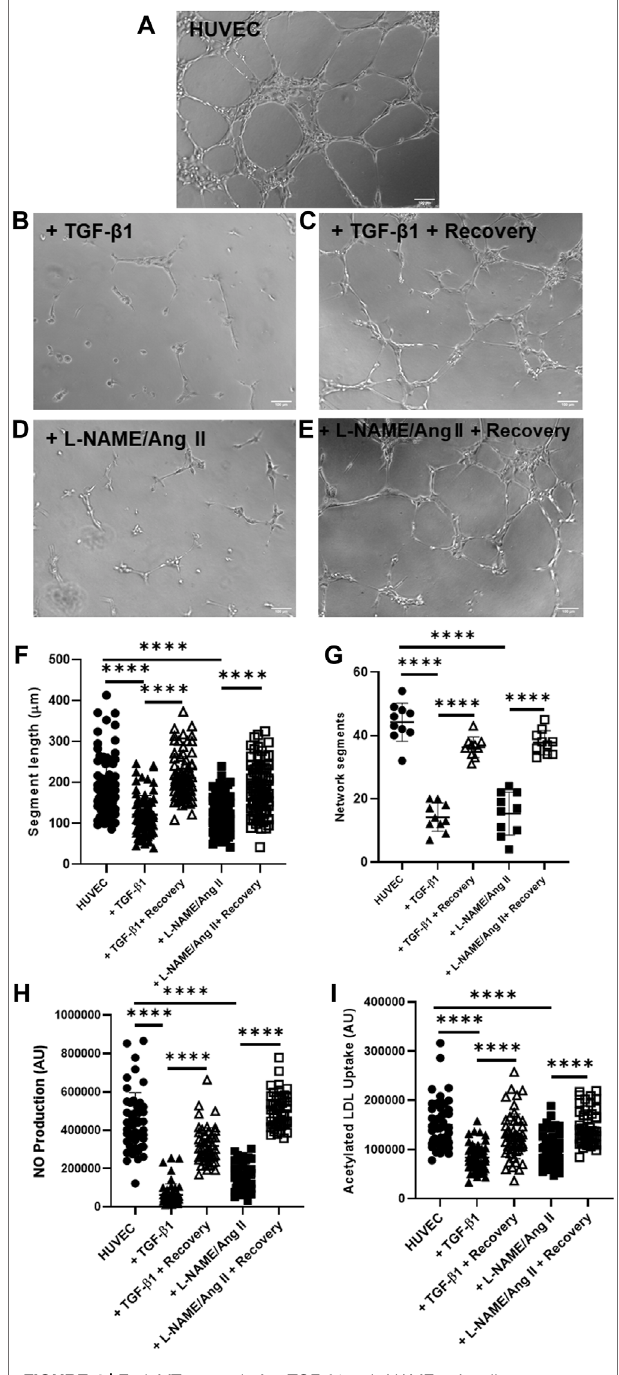
FIGURE 4 | EndoMT reversal after TGF- β 1 or L-NAME + Ang II stress removal restores endothelial function in HUVECs. Representative images of Matrigel ® network segment assays for control HUVECs (A) , HUVECs after day4ofEndoMT(withTGF- β 1orL-NAME+AngII) (B,D) ,andrecovered HUVECs (day 6 after removal of EndoMT inducing agents) (C,E) ; Scale bar — 100 µm (F) shows quanti fi cation of segment length for n = 85 segments (G) shows quanti fi cation of network segments for n = 10 fi elds of view. Endothelial function was also assessed with fl uorescence assays for (H) NO production using DAF-FM ( n = 50 individual cells) and (I) acetylated LDL uptake ( n = 50 individual cells), with single-cell fl uorescence quanti fi ed.